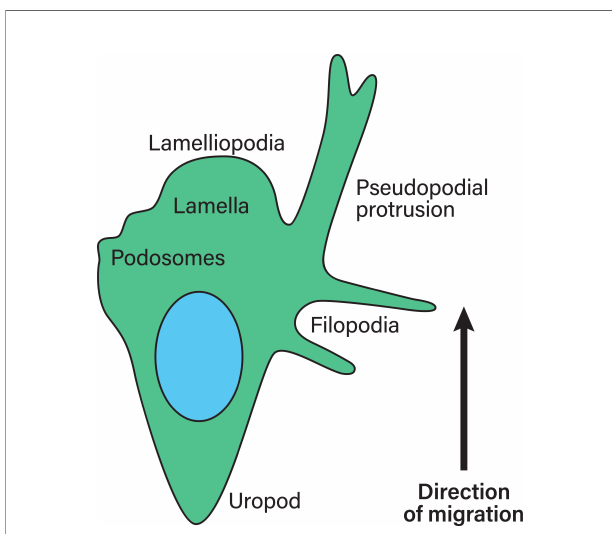
FIGURE 5 | Membrane structures inmigratingleukocytes. Actively migrating leukocytes on 2D surfaces formdistinct membrane structures. Depicted isthe lamellipodia, the actin-rich leading celledge, the lamella behind it(containing myosin II),as wellas the uropod orthe cell rear ofmigrating leukocytes, which are membrane structures that needto beformedduringpolarization to achieve directional migration.Pseudopodial protrusions are thick,arm-likemembrane protrusions in the direction of migration that mediate material uptake. Podosomes are smallmembrane protrusions which are associated with ECMdegradation usingproteases. Finally, fi lopodia arethin fi nger-likemembrane protrusionsused to probethe surroundingenvironment. Duringamoeboid migration in 3D, leukocytes form smallmembrane blebsto enact low adhesive forces on the